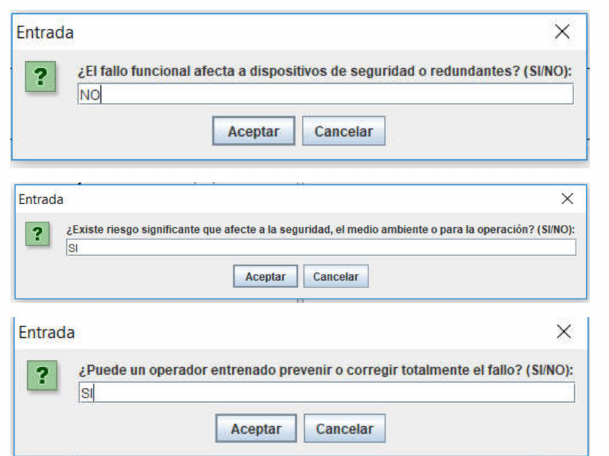
Figure 10. Data review window for the new chosen case using questions of operational context. Second stage: driven RCM to apply the maintenance